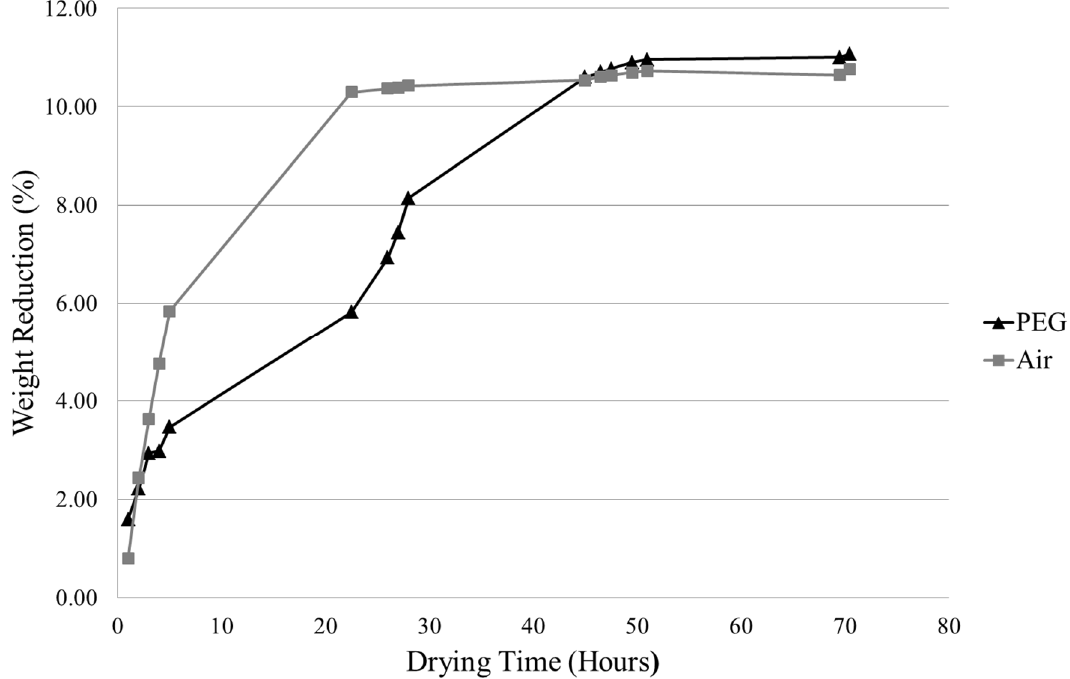
Figure 1. Comparison of sample weight reduction by PEG drying and air drying at 62% solid loading and using desiccant PEG4000 in a 30% concentrated aqueous